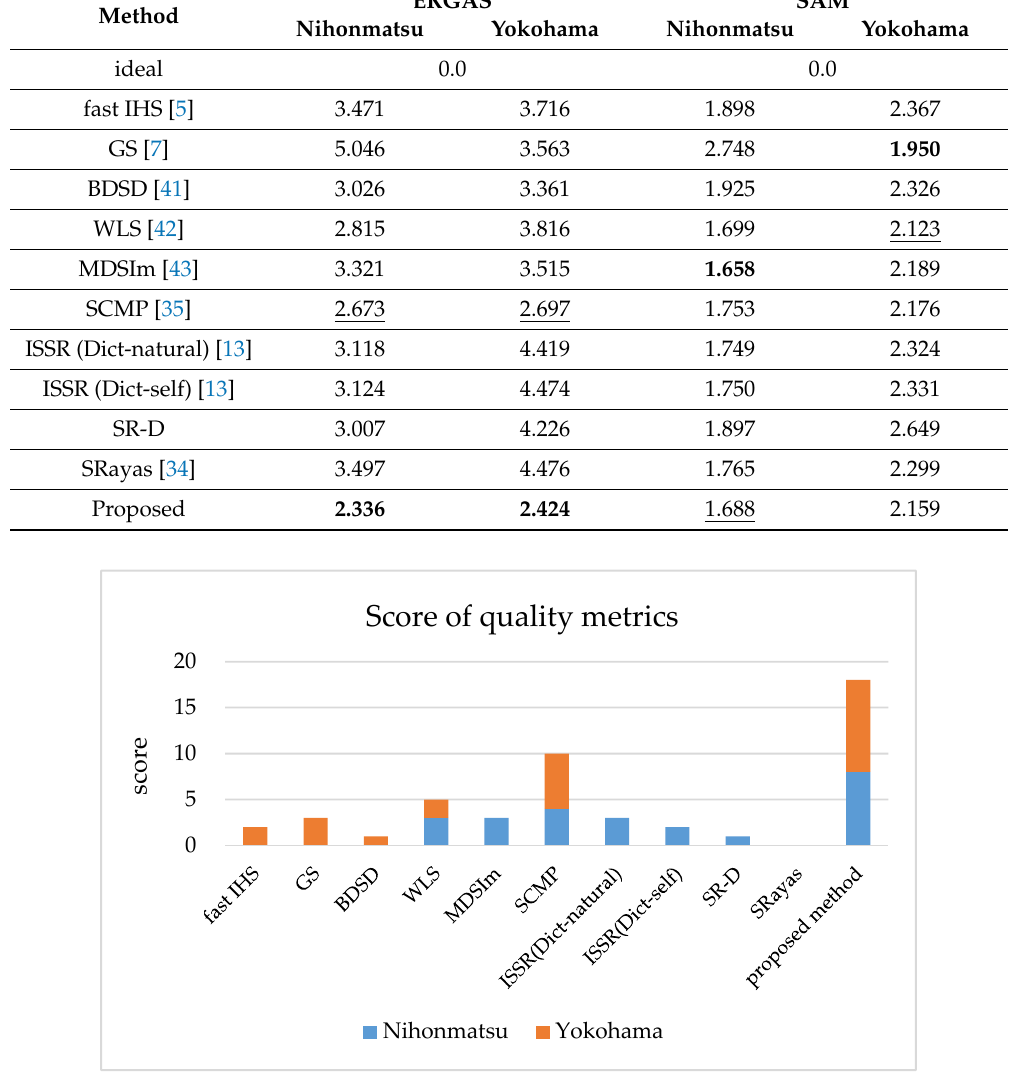
Figure 6. Scores of quality metrics.